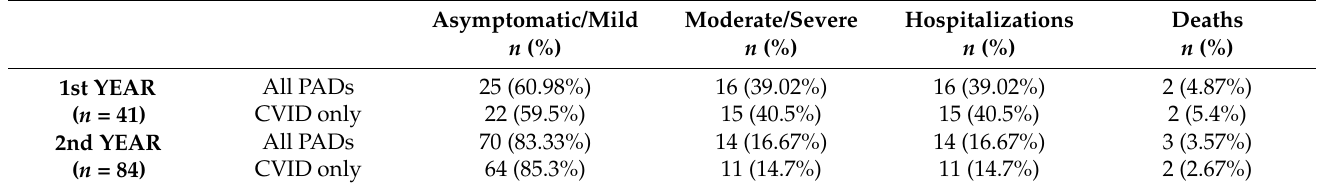
Table 1. Summary of absolute number and percentages of SARS-CoV-2 infections in PADs patients grouped according to COVID-19 stages. Hospitalizations and deaths observed in the first and second year of the cohort study were also